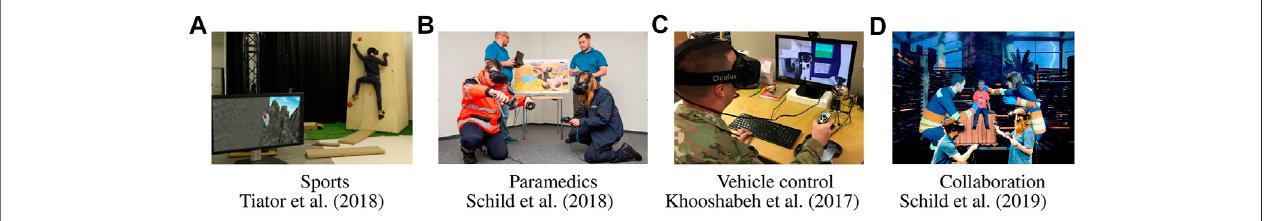
FIGURE 1 | VR training has been widely adopted by different domains. Image courtesy of the paper